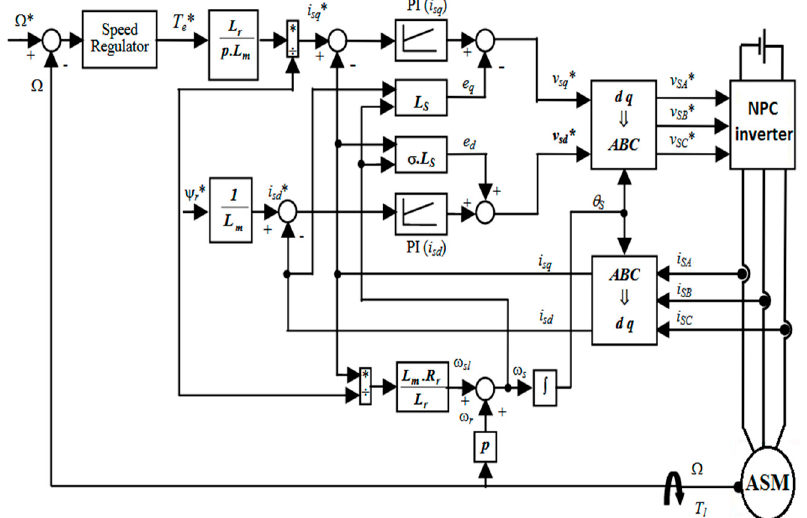
Figure 1. Block diagram of the induction machine drive.